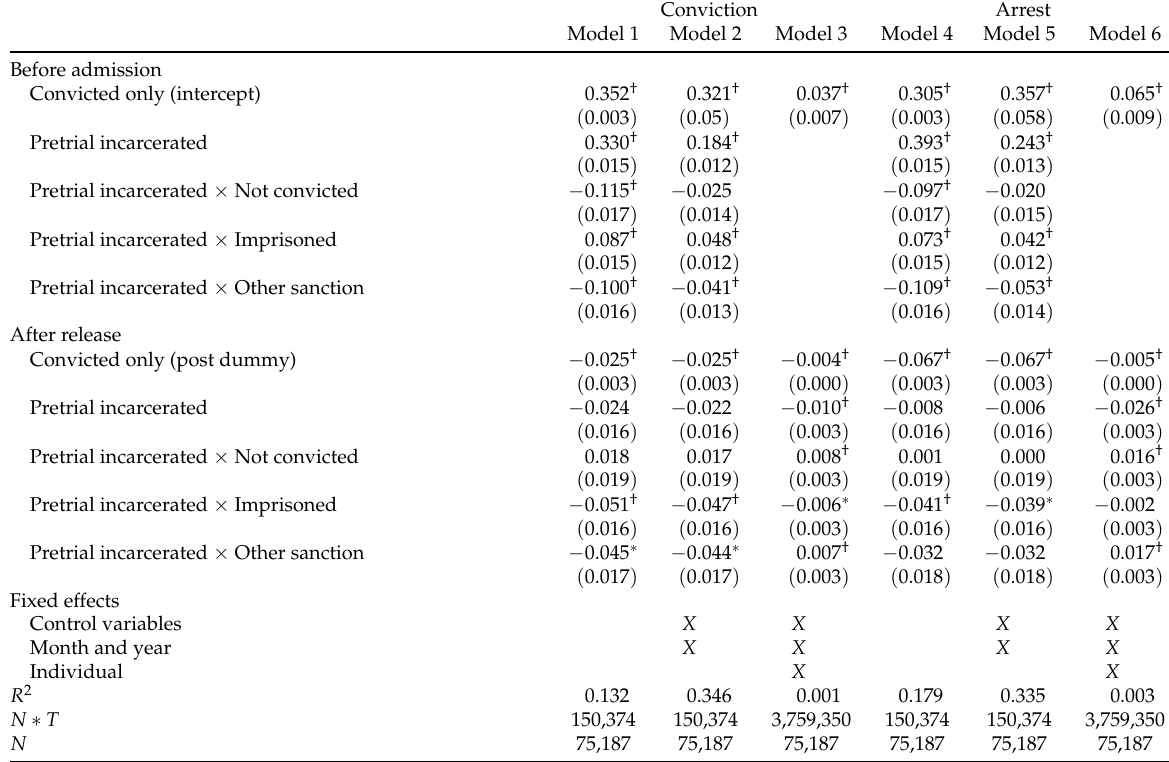
Table 4: Results from estimations of the change in criminal justice outcomes by pretrial detention